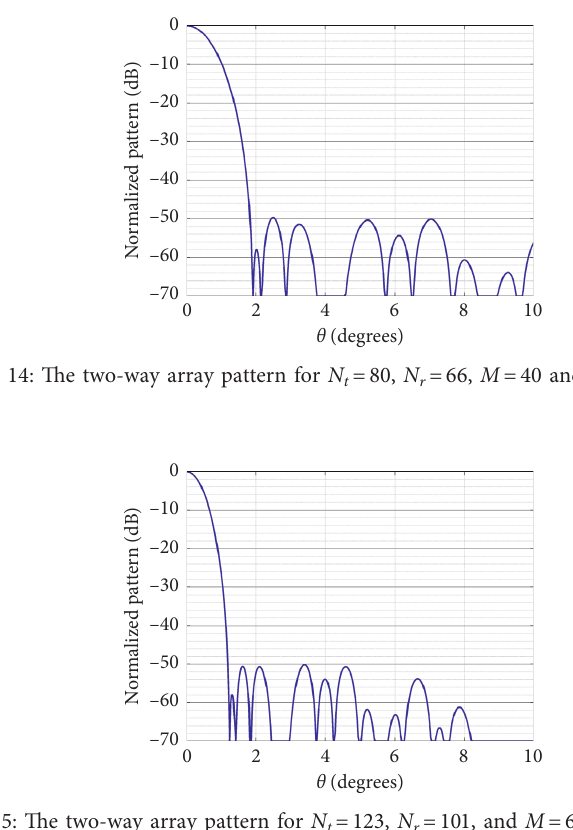
� 123, N � 101, and M � 61. SLL � − 50.15dB. t r